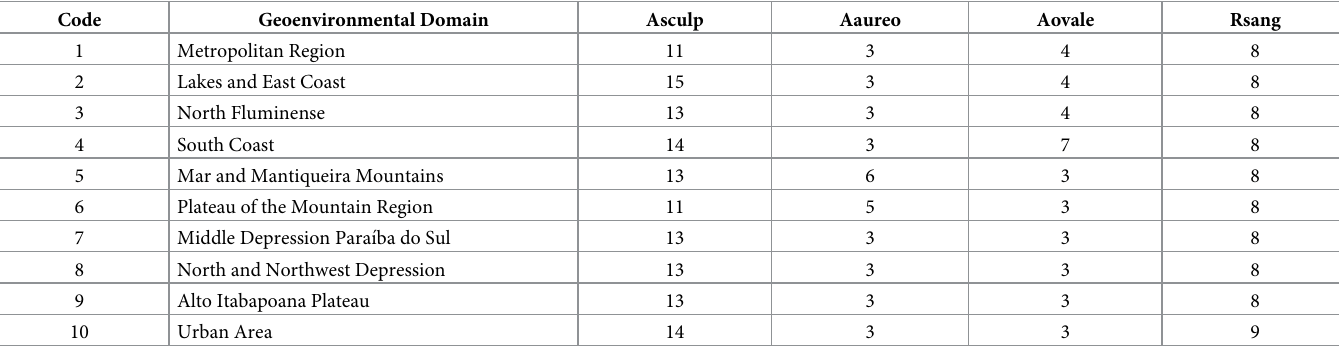
Table 3. Weights relating geoenvironmental domains in Rio de Janeiro state with potential vectors.